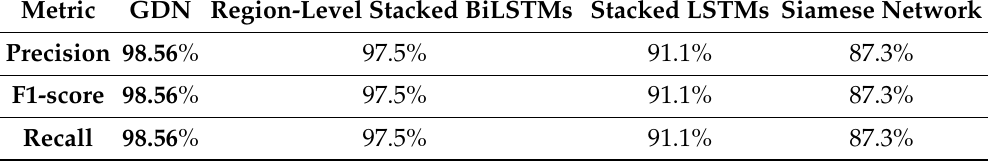
Figure 11. Model performance tracking of GDN part of the proposed GDN-GAN. ( a ) Accuracy for training and test phases. ( b ) Loss for training and test phases. Table 5. Performance evaluation in terms of precision, F1-score, and recall for different